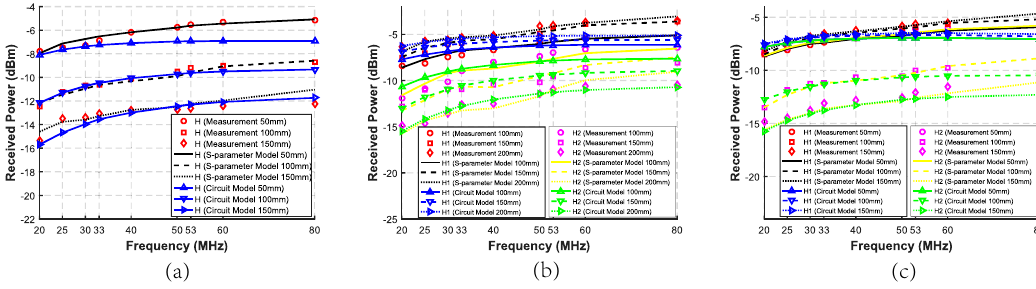
Figure 12. Measurement, simulated S-parameter model, and circuit model received power of two harvesters with different frequencies of the source and different distances where the forward and backward distances remain the same. ( a ) Case II-1: the SSSH case with distances of 50mm, 100mm, and 150mm between S and H. ( b ) Case II-2: the SSMH-SA case with distances of 100mm, 150mm, and 200mm between S and H2. ( c ) Case II-3: the SSMH-OP case with distances of 50mm, 100mm, and 150mm between S and H2.